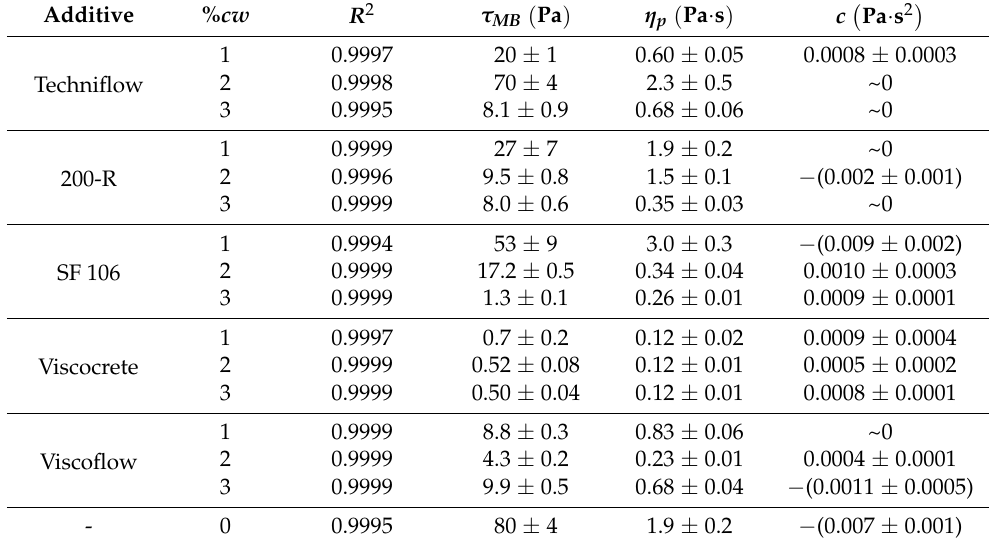
Table 7. Parameters of modified Bingham equation. Effect of additives on Armaduro CP (0.35 % w / c ).